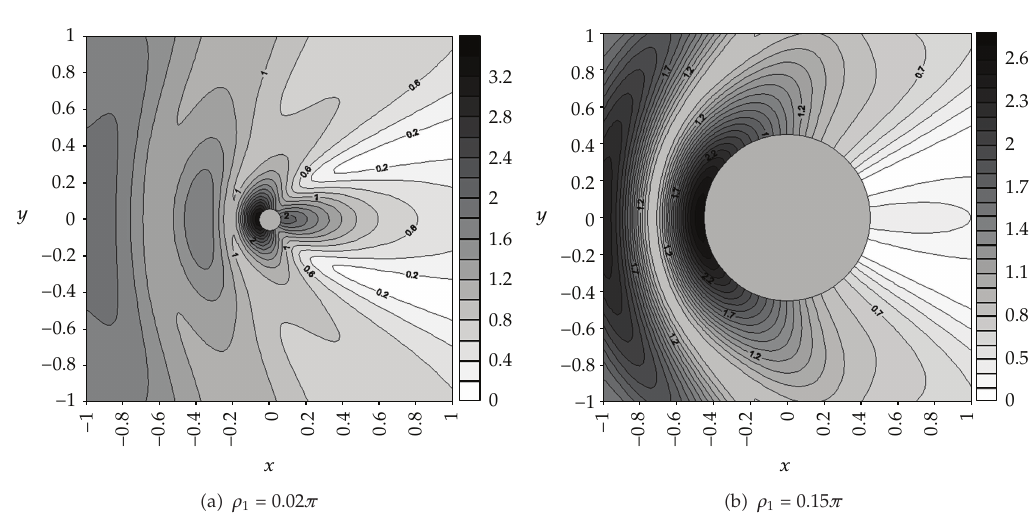
Figure 4: E ff ects of island on wave scattering for α (cid:4) 1 (cid:2) ρ 0 (cid:4) 0 . 2 π , f p (cid:4) 1, n 0 (cid:4) 0 . 5 (cid:3) .